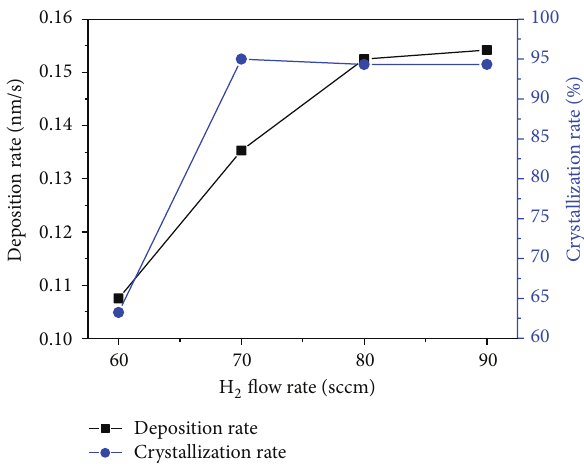
Figure 2: The deposition and crystallization rate as a function of H 2 flow